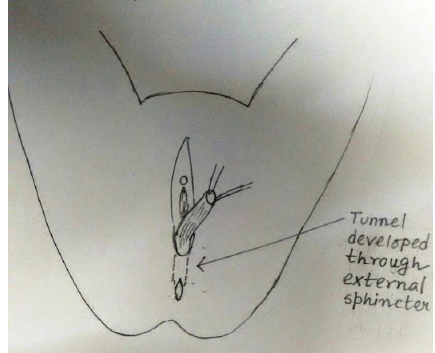
Figure 11: Tunnel developed for mobilisation of